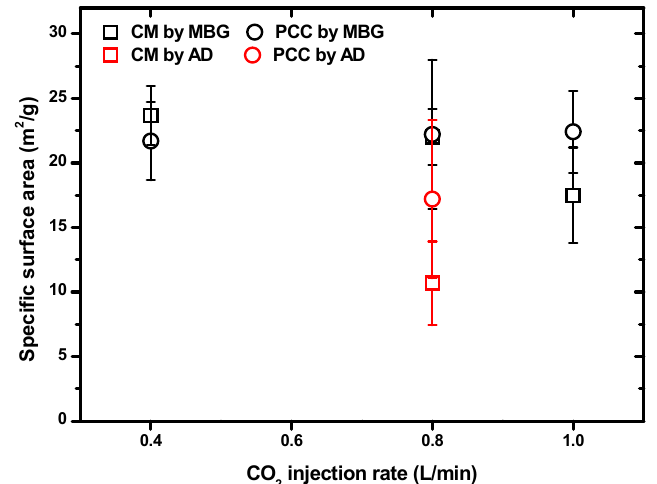
Figure 4. SSA of CaCO 3 produced by CM and PCC from gypsum (squares □ ) and Ca(OH) 2 (circles ○ ) respectively. The effect of the CO 2 injection methods (MBG and AD) on the SSA were marked in black and red, respectively. The horizontal axis indicates the CO 2 injection rate into the calcium-source suspensions. The SSA results using Ca(OH) 2 are from our previous paper [11]. The standard deviation was obtained from the repeated experimental results at least